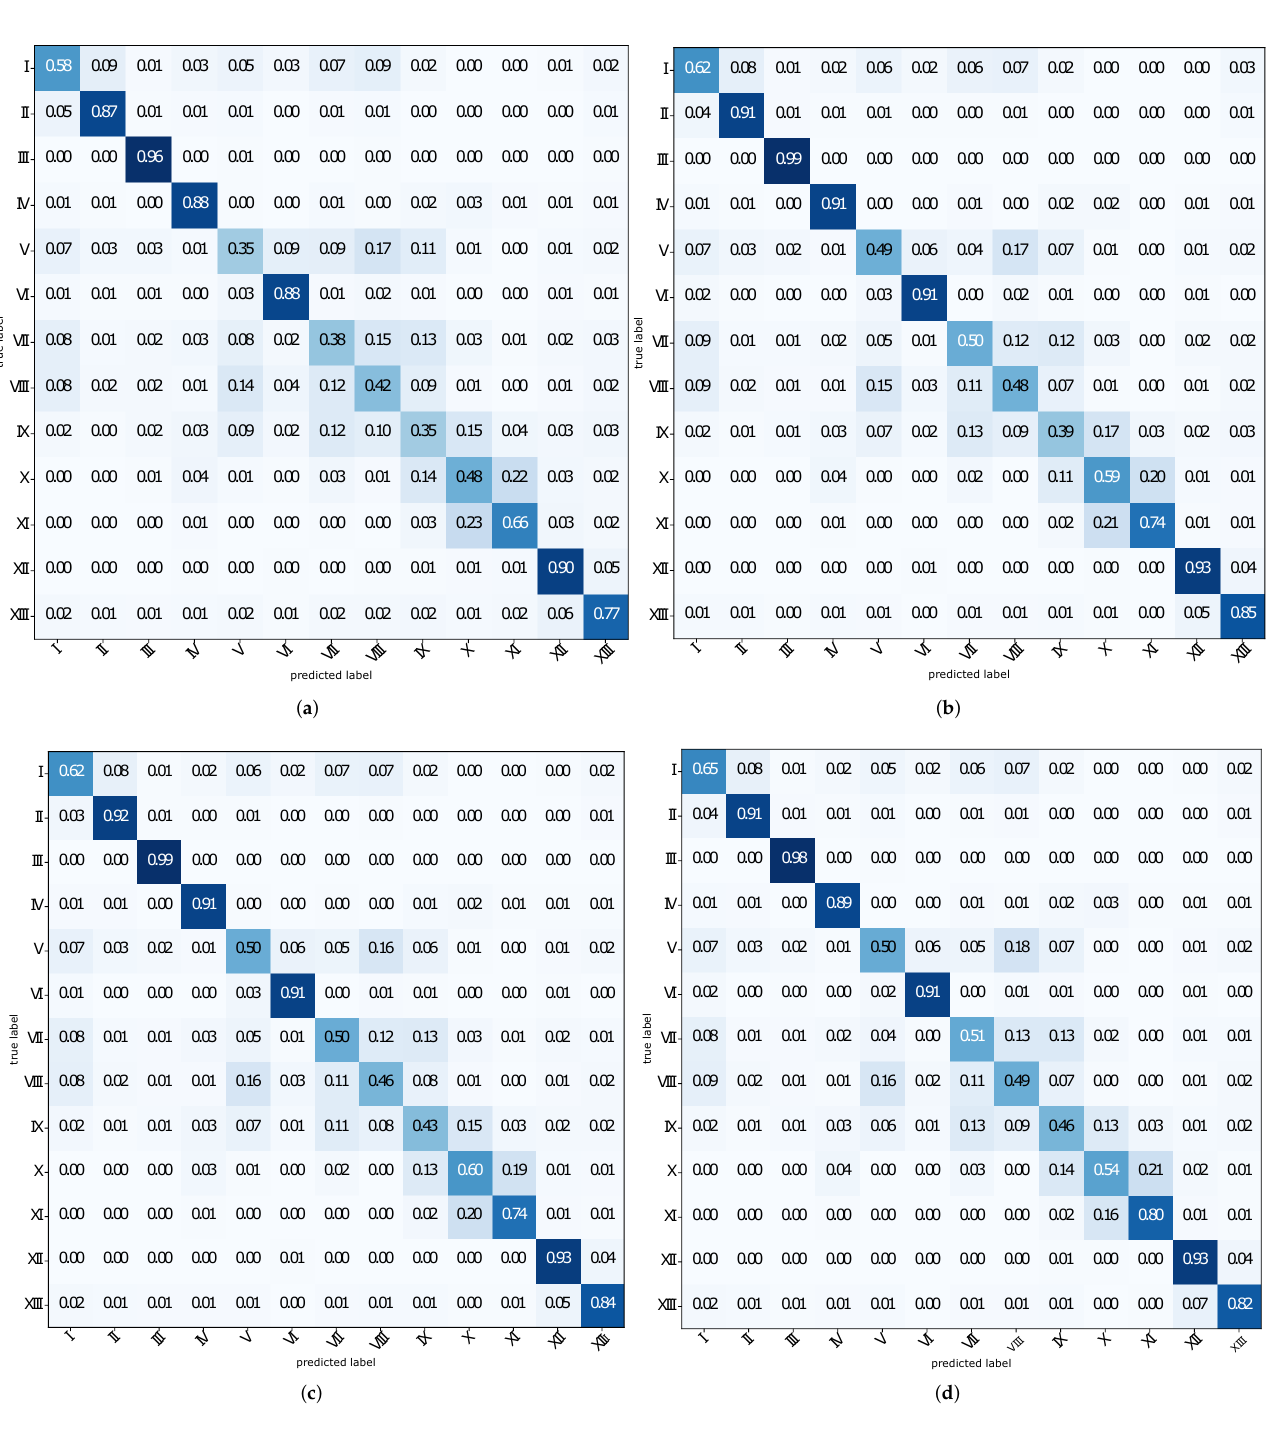
Figure 7. The confusion matrices for classification using different LoAs: ( a ) for using LoA 0 only. As such, here only the most basic OWL-classes were used; ( b ) for using LoA 0 and 1; ( c ) for using LoA 0 to 2; ( d ) for using LoA 0 to 3 (all OWL